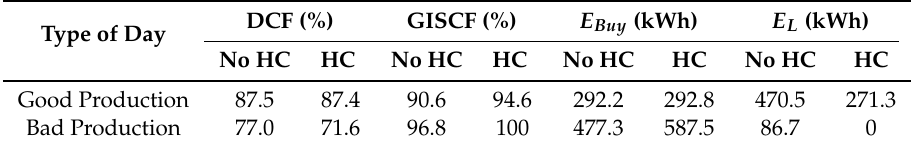
Figure 15. Daily simulation for and a cluster of 200 households with 4000 W of PV power and 4000 Wh of energy storage each. Comparison of HC enhancement strategies. Table 3. Indexes and energy for 2 days with and without HC enhancement